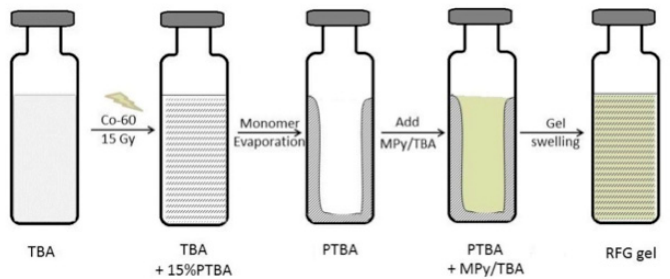
Figure 4. A pictorial representation of the processes involved in the preparation of a reformed radio- fluorogenic (RFG) gel from tertiary-butyl acrylate (TBA) and maleimido-pyrene